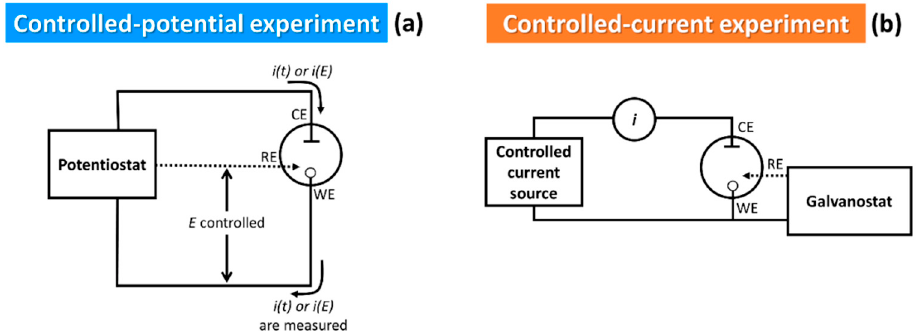
Figure 3. Schematic representation of ( a ) controlled ‐ potential and ( b ) controlled ‐ current experiments.